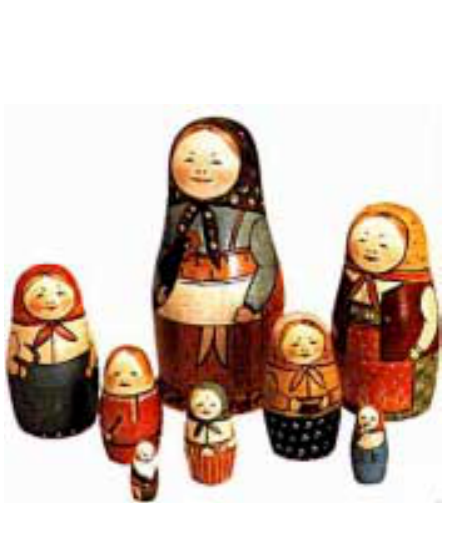
Figure 1a : Matryoshka Dolls and Matryoshka -Type